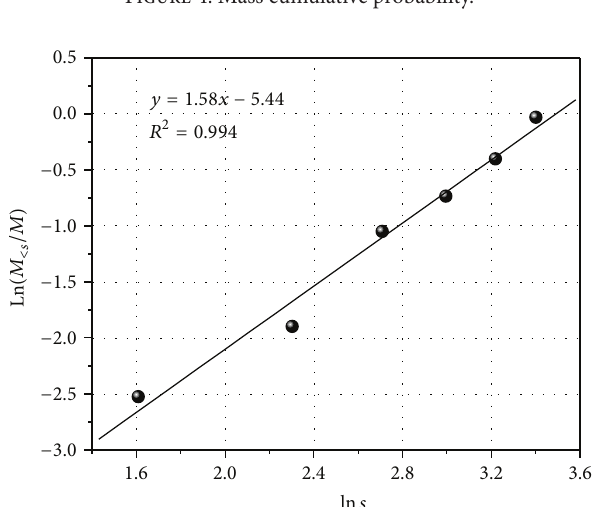
Figure 4: Mass cumulative probability.